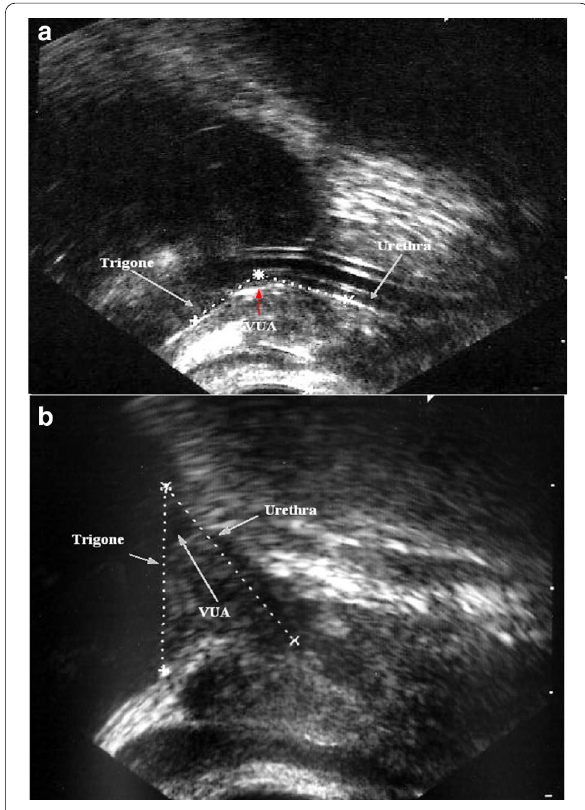
Fig. 3 Measurement of VUA in midline longitudinal view. A VUA measurement in patient with urinary catheter. B VUA measurement in patient without urinary catheter